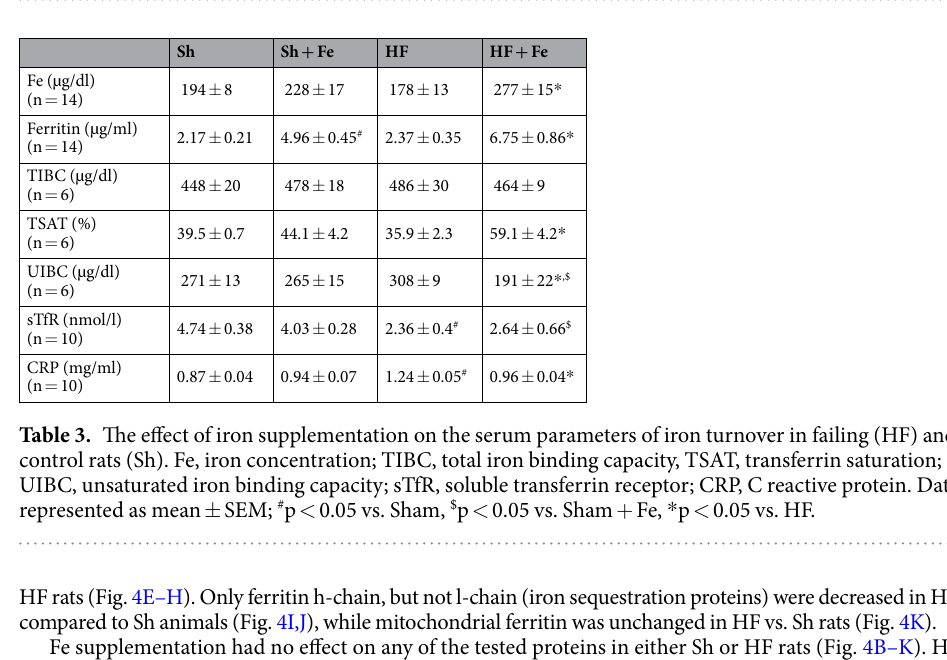
Table 2. The effect of iron supplementation on the hematology parameters in failing (HF) and control rats (Sh). Hgb, hemoglobin concentration; Hct, hematocrit; MCV, mean corpuscular volume; MCH, mean corpuscular hemoglobin; MCHC, mean corpuscular hemoglobin concentration; RBC, red blood cell count; WBC, white blood cell count; PLT, platelets; Ret, reticulocyte count. Data is represented as mean ± SEM.